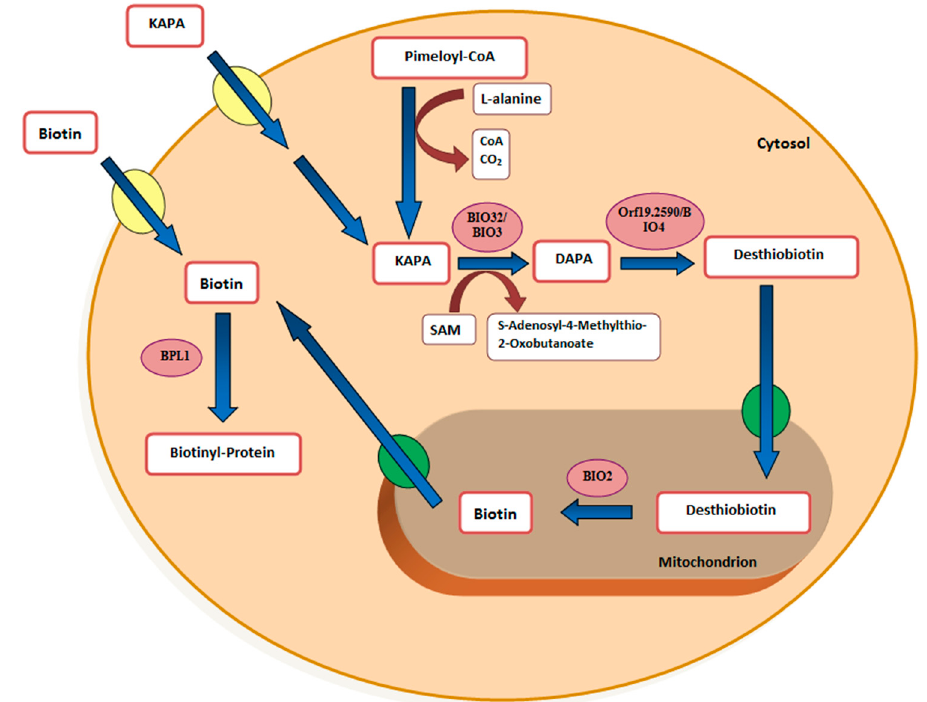
Figure 1. Diagram of proposed biotin biosynthesis pathway in Candida albicans based on a model available at the Candida Genome Database [18] and mitochondrial targeting predictions for BIO32 , BIO3 , BIO4 , BIO2 , and BPL1 . This model assumes that biotin biosynthesis occurs in the cytoplasm except for the conversion of desthiobiotin to biotin by BIO2 , which occurs in the mitochondrion. Biotin, desthiobiotin, and KAPA (8-amino-7-oxononanoate) could be taken up by two different transporters, which are VHT1 and HNM3/BIO5 , respectively. Note that the mitochondrial transporters for biotin uptake, desthiobiotin uptake, and biotin secretion may be different manifestations of the same transport system. This mitochondrion model is based on different roles of biotin and desthiobiotin in growth and filamentation.